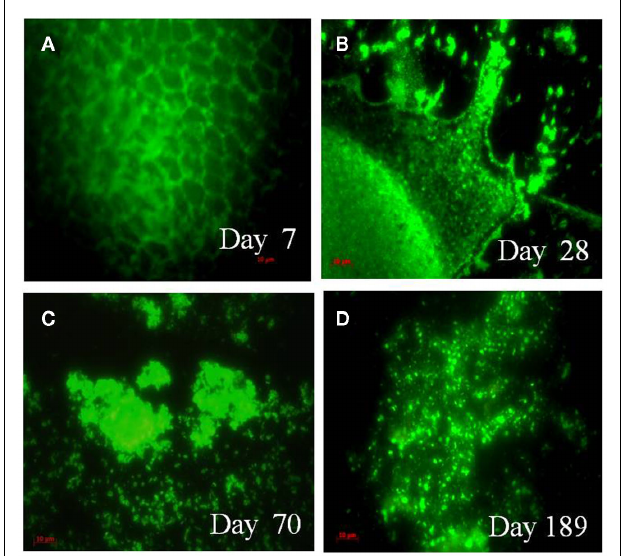
FIGURE 3 | Epifluorescent micrographs of attachment and utilization of shrimp chitin by V. cholerae O1 in the MW–CC microcosm. Fluorescent monoclonal antibody (DFA) specific for V. cholerae O1 obtained from New Horizon Diagnostics, were used and the stained cells were visualized using an epifluorescence microscope (Carl Zeiss model Axioskop 40). Microscopic images were captured digitally (AxioCam MRc) and processed using Adobe Photoshop (version 5). (A) Attachment and colonization of V. cholerae O1 on a chitin chip at day 7; (B) clusters of biofilm bound cells on a decaying chitin chip at day 28; (C) thick biofilm and small residues of chitin chips colonized by V. cholerae O1 (utilization of chitin) at day 70; (D) typical cells, dividing cells, together with mostly coccoid cells of V. cholerae O1 in the homogenate of HCl-treated chitin residue at day 189. (Scale bars in red indicate 10 μ